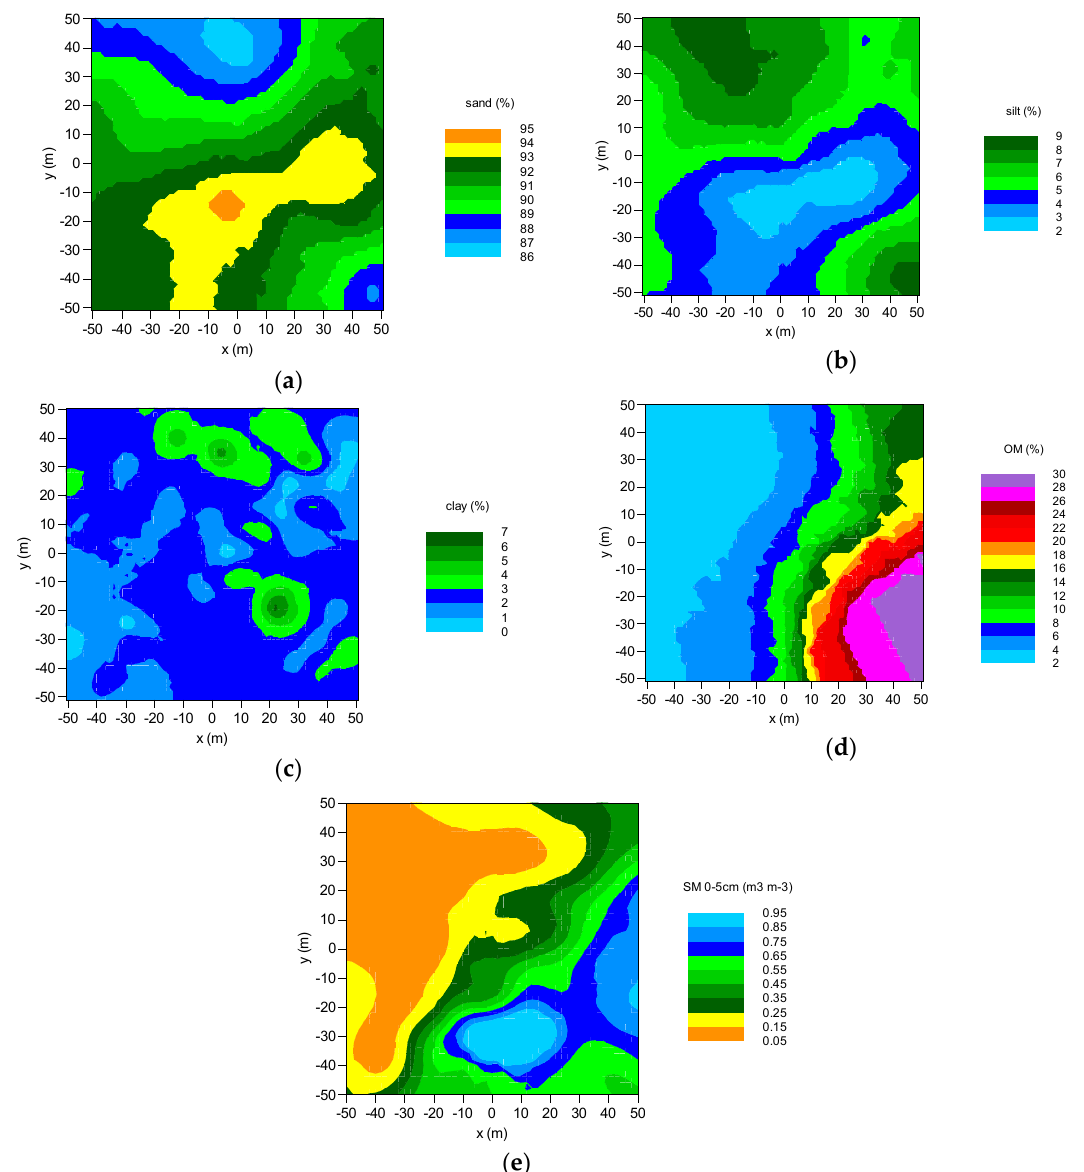
Figure 2. Spatial distributions of ( a ) sand, ( b ) silt, ( c ) clay, and ( d ) organic matter (OM) content in soil on the Bubnów test site. The exemplary distribution of soil moisture (SM) acquired during a field campaign on 18 May 2017 (138 DOY) is shown in figure ( e ). The ELBARA tower is located at (0,0) point of each map.